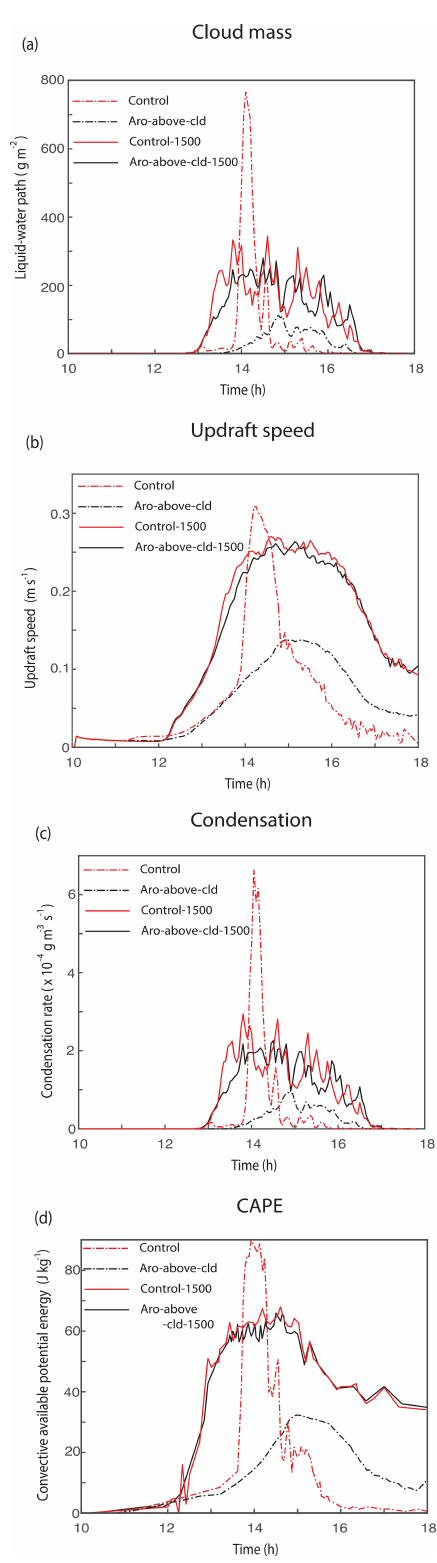
Figure 8. Time series of the domain-averaged (a) liquid water path, (b) updraft speed, (c) condensation rate and (d) CAPE in the stan- dard